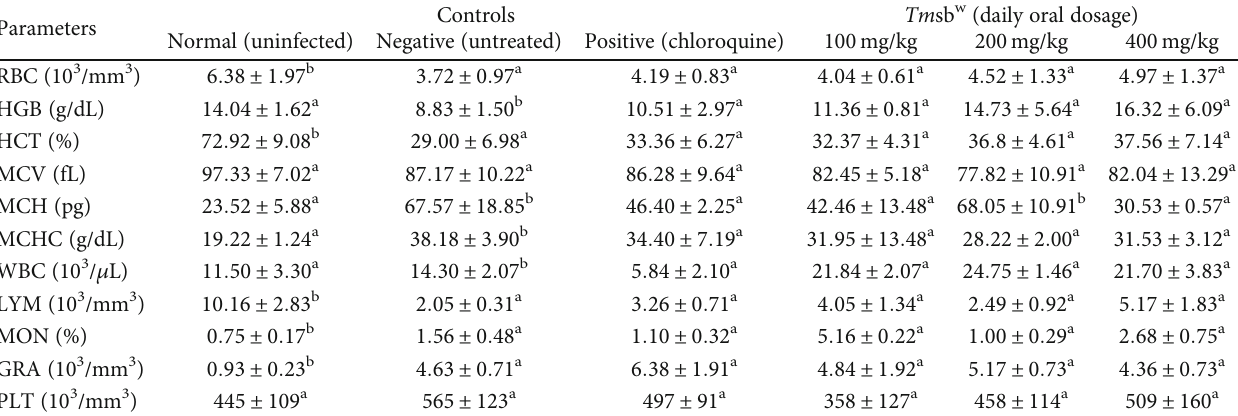
Table 3: E ff ects of Tm sb w on some hematological parameters in Pb B-infected mice.